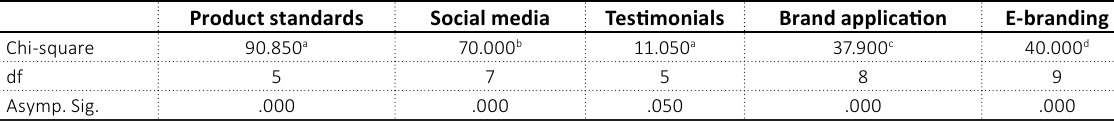
Table 7. Cronbach’s goodness of fit